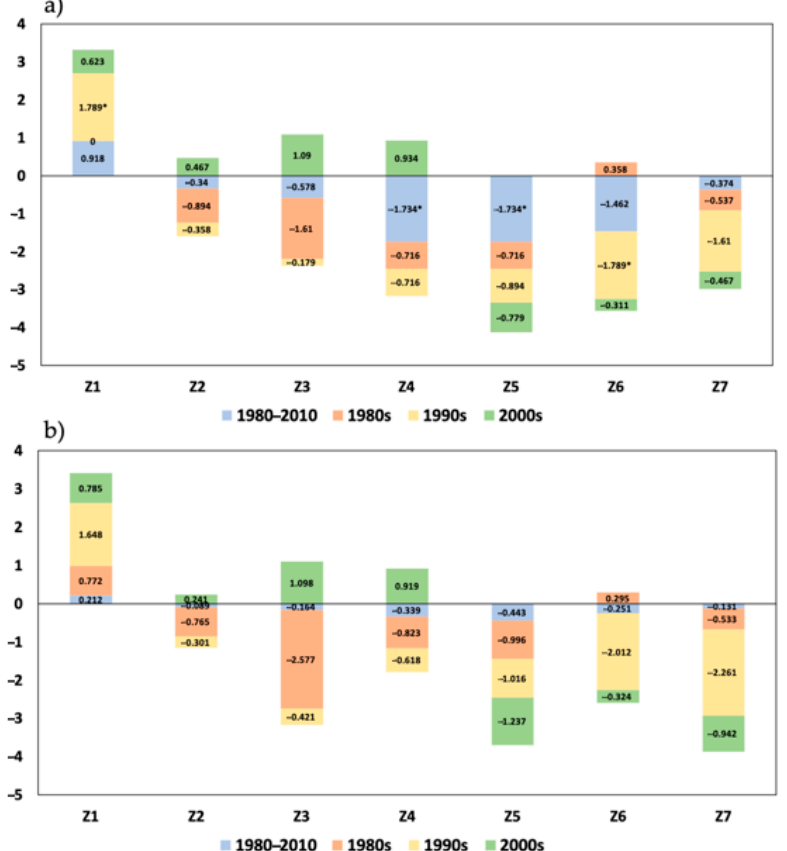
Figure 3. ( a ) Mann–Kendall’s test statistic and ( b ) Sen’s slope of the trend of rainy season onset for the for the entire period (1980–2010) and each decade (1980s, 1990s, and 2000s) for Northwest (Z1), Northeast (Z2), North Central (Z3), Central Coast (Z4), South Central Coast (Z5), Central Highlands (Z6), and South (Z7) agroclimatic zones. Asterisk indicates that the Mann–Kendall’s test statistic values is statistically significant at 90% level.